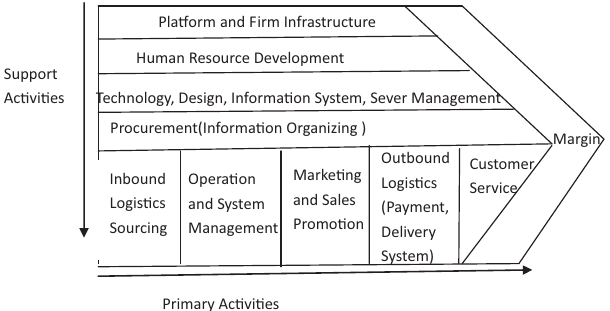
Figure 1. The adapted value chain model for haitao shopping